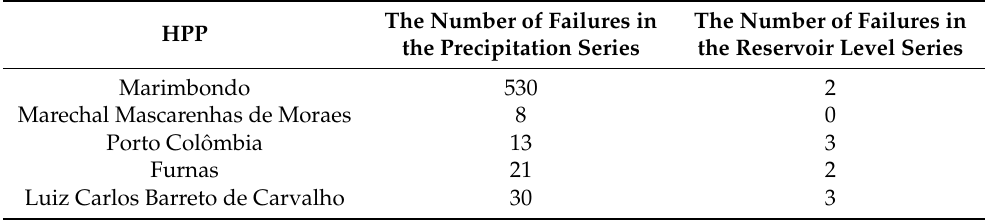
Table 3. Number of failures in the precipitation and reservoir level data series for each of the hydroelectric plants located on the Rio Grande operated by